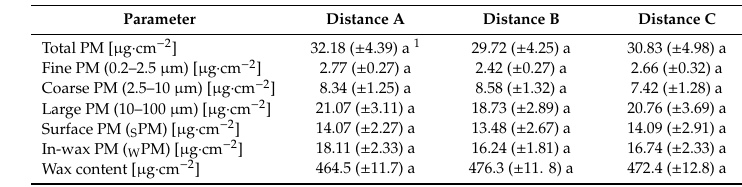
Table 8. E ff ect of distance to the road on accumulation of total PM (0.2–100 µ m), fine PM (0.2–2.5 µ m), (2.5–10 µ m), large (10–100 µ m), surface PM ( S PM), in-wax PM ( W PM), and wax content on apple